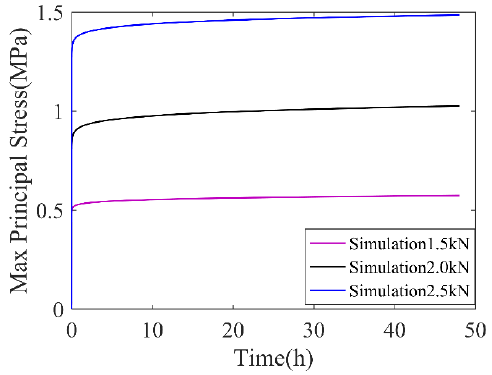
Figure 15. Time variation of maximum principle stress of reference point ( T = 23 ◦